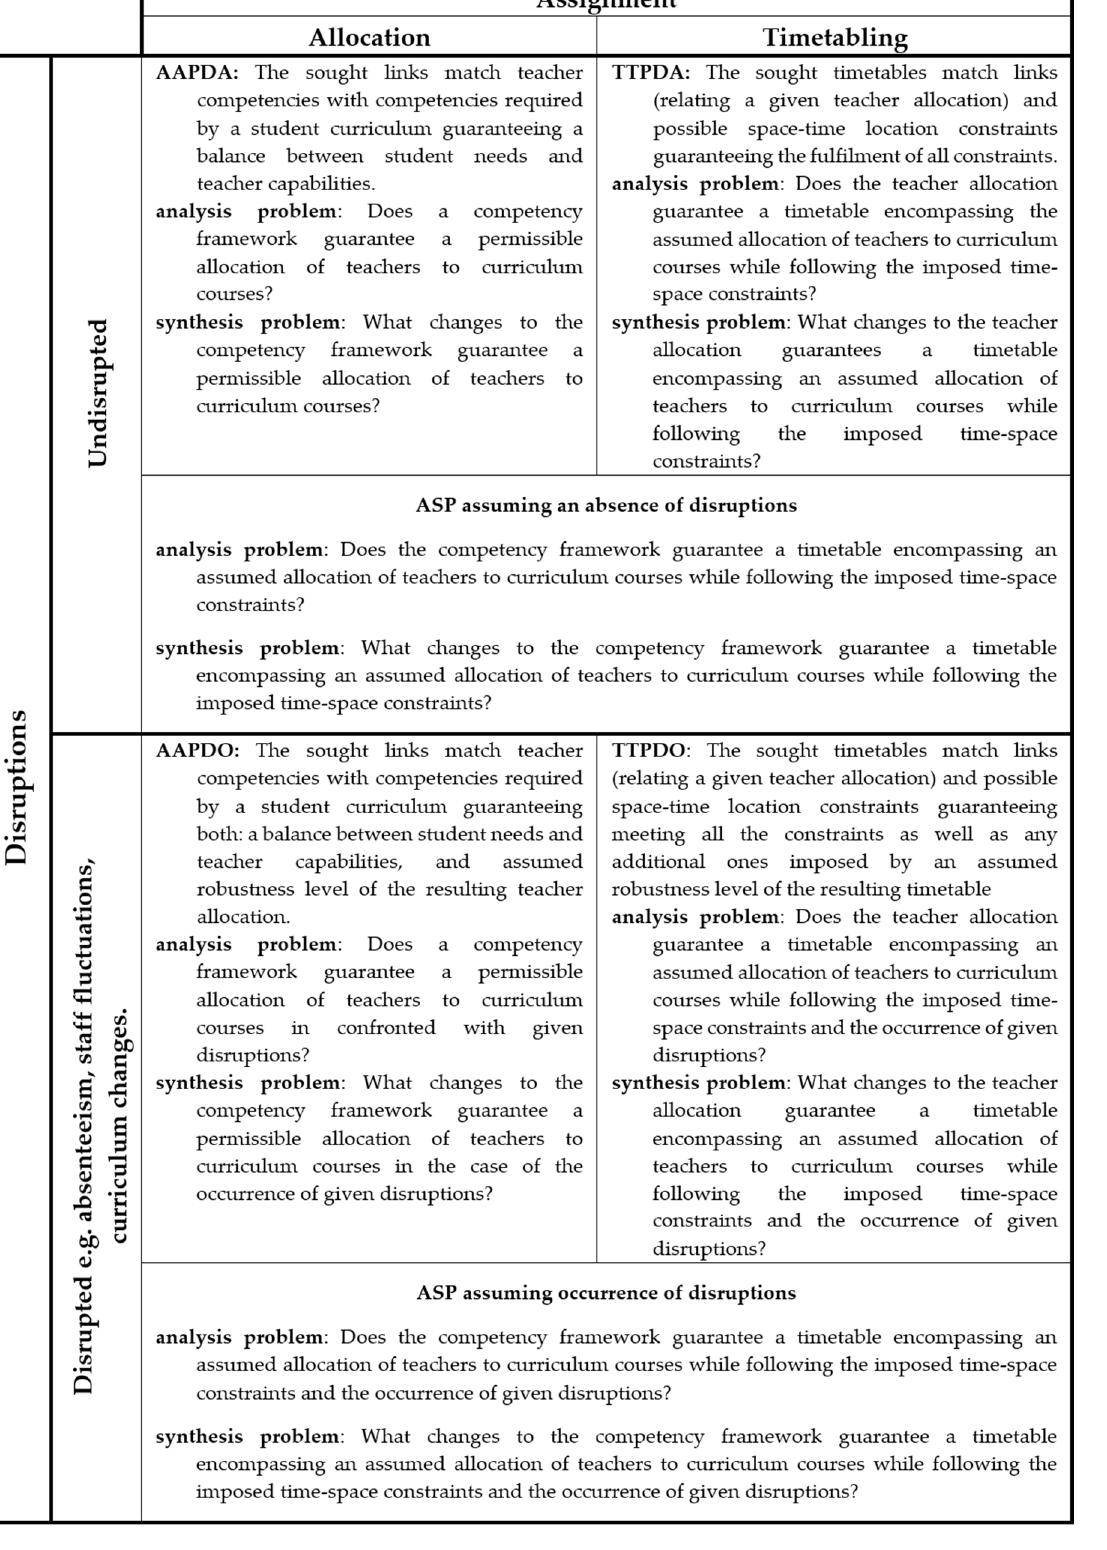
Figure 1. Taxonomy of teacher assignment problems.